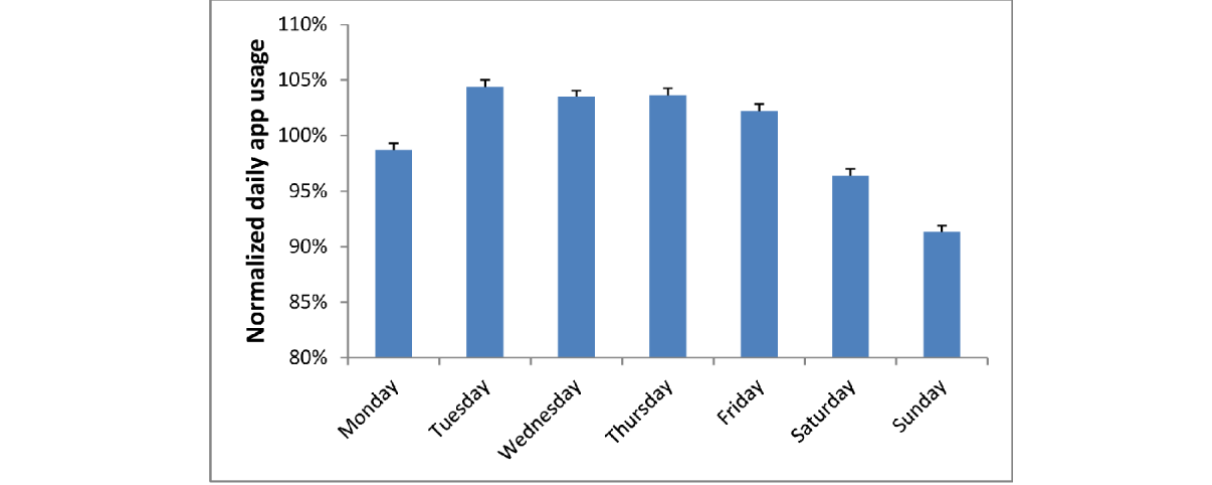
Figure 7. Daily app launches normalized by the weekly average for the period between November 2019 and July 2020. Bars indicate mean app usage by the days of the week. Error bars indicate SD values.